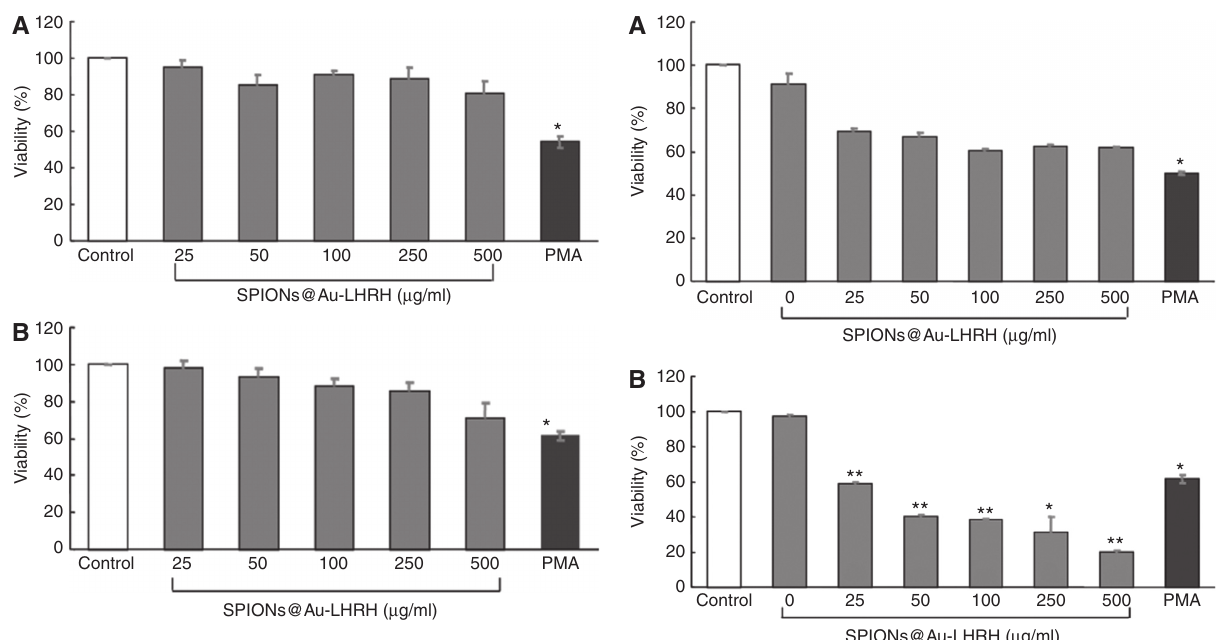
Figure 3 Measurement of cell viability of (A) GT1-7 neurons and (B) LNCaP cells pretreated with SPIONs@Au-LHRH (25–500 μ g/ml) for 24 h. The viability was measured based on metabolic activity (reduc- tion of resazurin to resorufin) as described in the Methods section. The viability of cells not exposed to SPIONs@Au-LHRH was set at 100%. Exposure to PMA (10 μ g/ml) represented a positive control. Each data point indicates mean ± SD of three to five independent